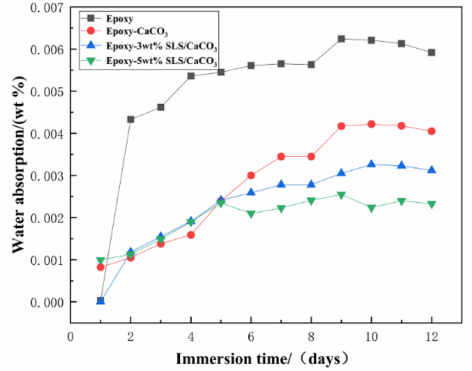
Figure 14. Water absorption of various coatings over immersion